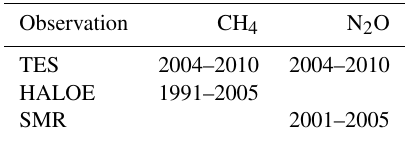
Table 3. Summary of CH 4 and N 2 O satellite observations used in this